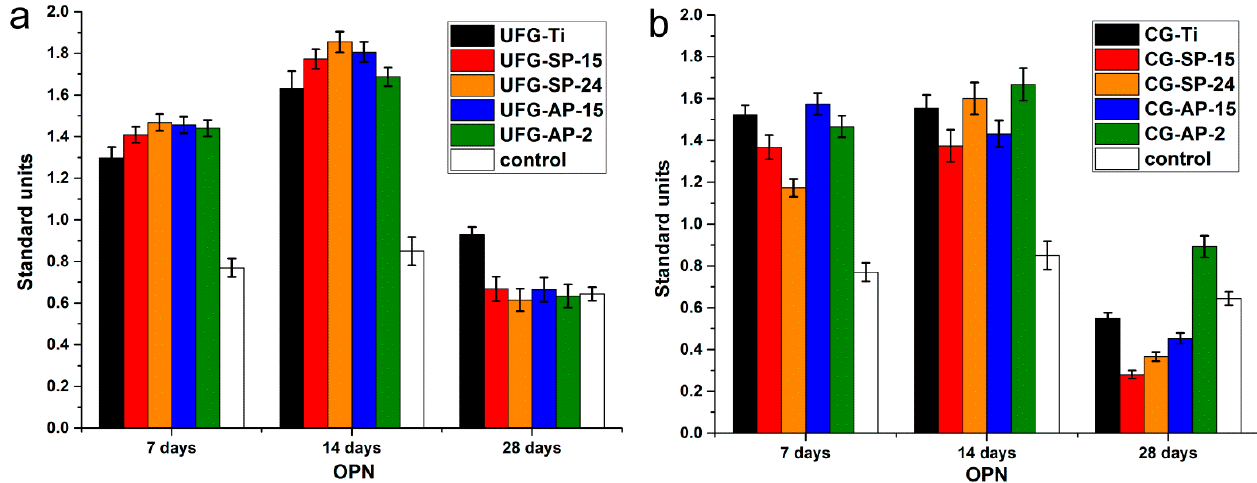
Figure 8. Osteopontin production by MC3T3-E1 osteoblasts on UFG series—( a ) and CG series—( b ). Each value represents mean ± S.D. from five independent experiments ( p < 0.05).